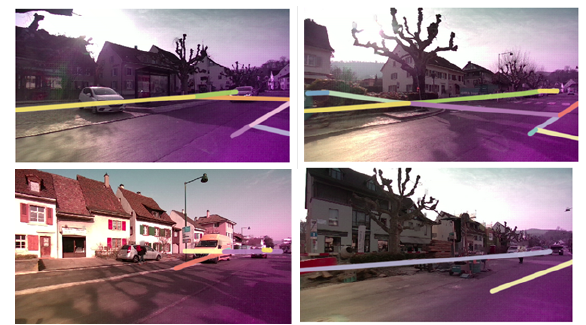
Figure 3. Examples of street centre line cues that are difficult to read because of a complex network situations (top), because of registration error (bottom left) or lack of directional information (bottom right) (images: (Nebiker et al., 2021); geo-data: (Bundesamt f¨ur Landestopografie swisstopo,